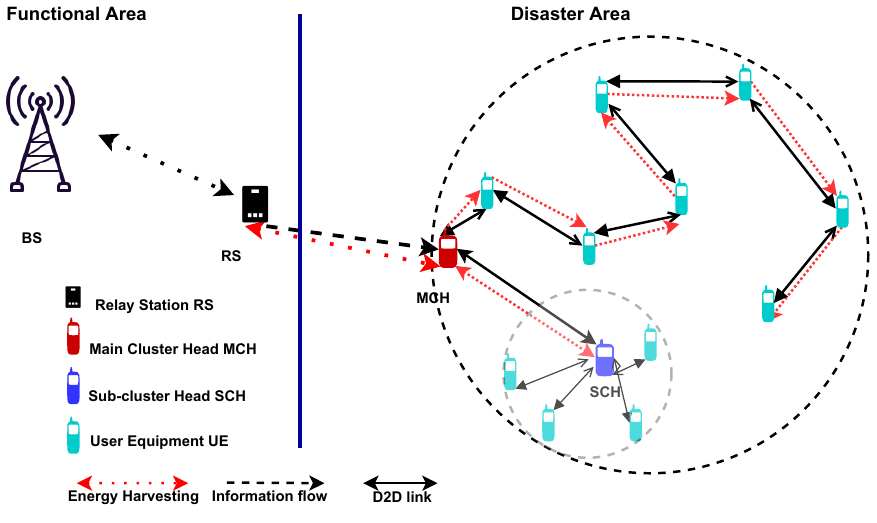
Figure 3. Energy transfer scheme within a